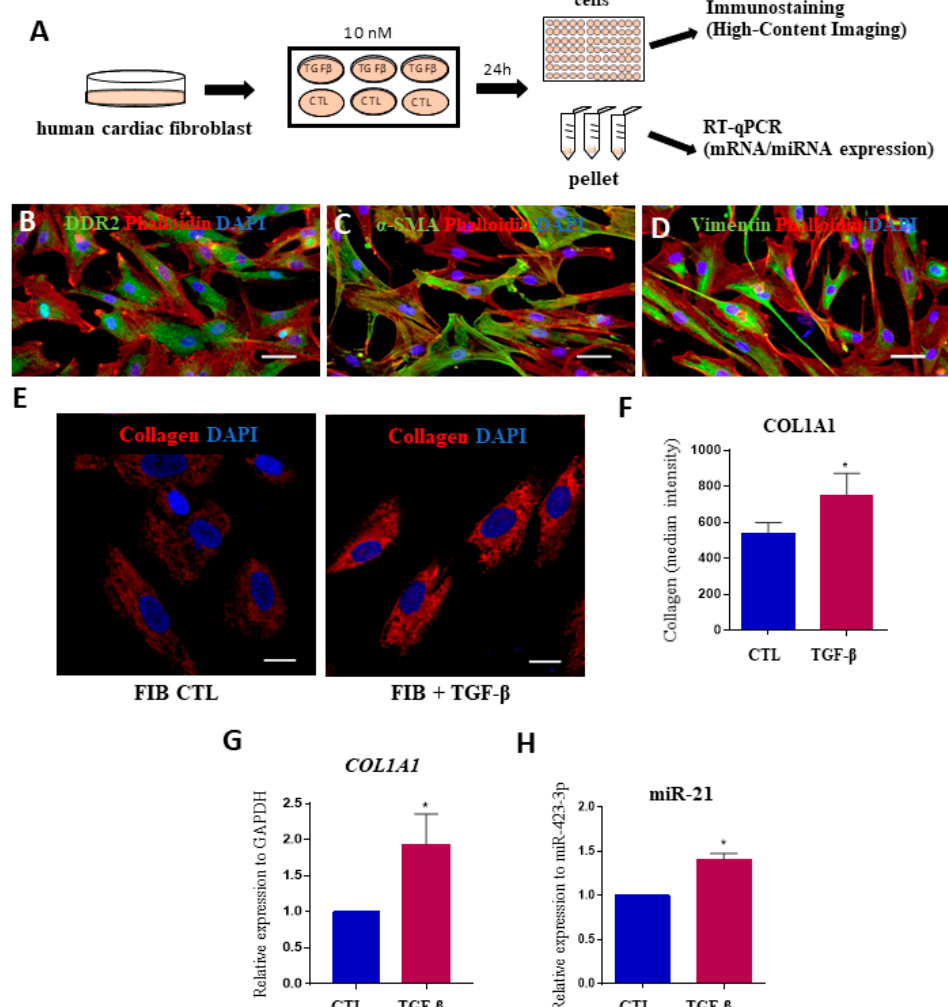
Figure 4. Assessment of miRNA expression in human cardiac fibroblasts after stimulation with TGF β . ( A ) Experimental design. ( B ) Validation of human cardiac fibroblasts markers by immunostaining for DDR2 ( A , green), α -SMA ( B , green) and vimentin ( C , green). In all samples, the cytoskeleton was stained with phalloidin (red) and nuclei were stained with DAPI (blue). Scale bars = 50 µ m; ( E ) Staining for collagen type I (red) and nuclei were stained with DAPI (blue) after 24 h of incubation with TGF- β . Scale bars = 20 µ m; ( F ) Quantification of COL1A1 expression by measurements of median fluorescence intensity and ( G ) gene expression by RT-qPCR. ( H ) Expression levels of miR-21-5p in human cardiac fibroblasts stimulated or not with TGF- β 1, evaluated by RT-qPCR, normalized with miR-423-3p and represented by fold change expression. CTL = unstimulated cardiac fibroblasts. TGF- β = cardiac fibroblasts stimulated with TGF- β . Values represent the mean ± SEM of n = 3 replicates group and were evaluated using Student’s t -test. * p < 0.05.